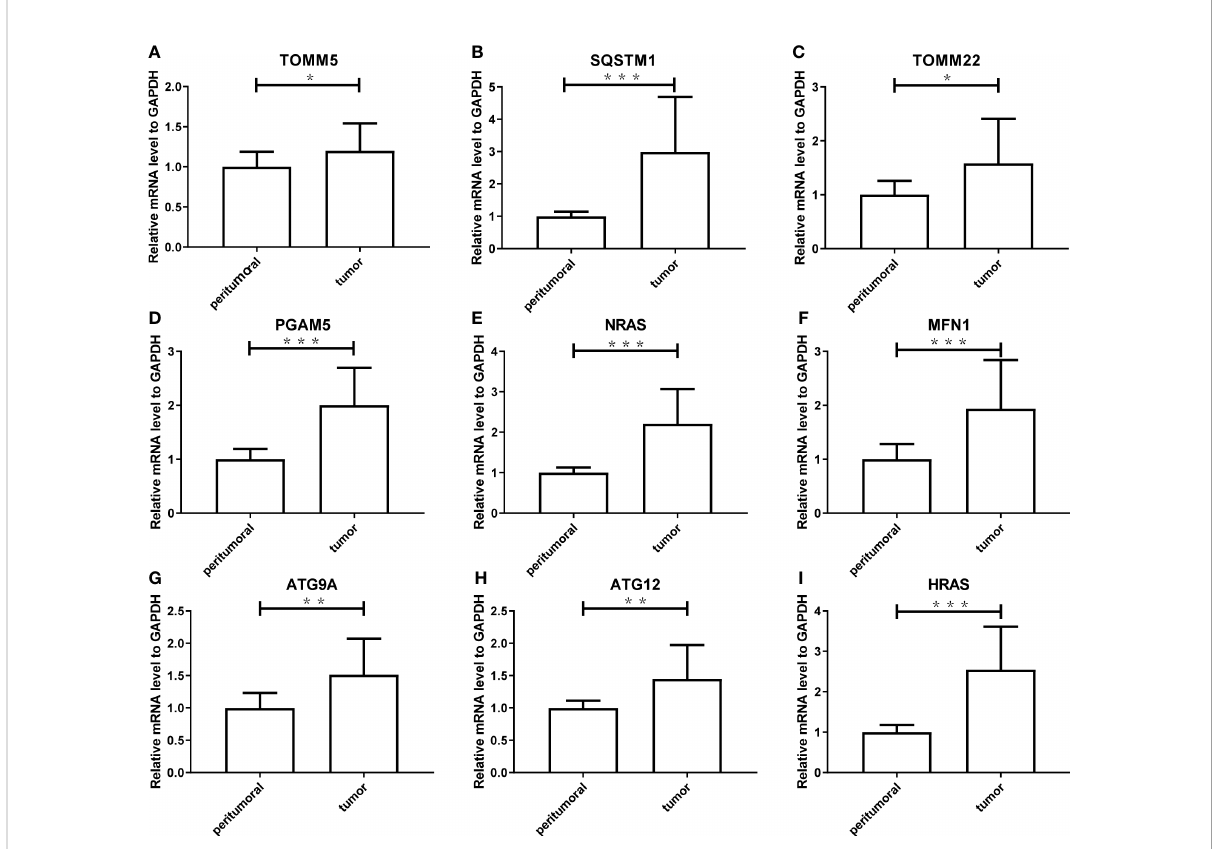
FIGURE 11 The experimental validation of nine genes consisting the risk model using Real-Time PCR, including TOMM5 (A) , SQSTM1 (B) , TOMM2 (C) , PGAM5 (D) , NRAS (E) , MFN1 (F) , ATG9A (G) , ATG12 (H) , HRAS (I) . The asterisks represent the p value (*: p < 0.05; **: p < 0.01; ***: p < 0.001). PCR, polymerase chain